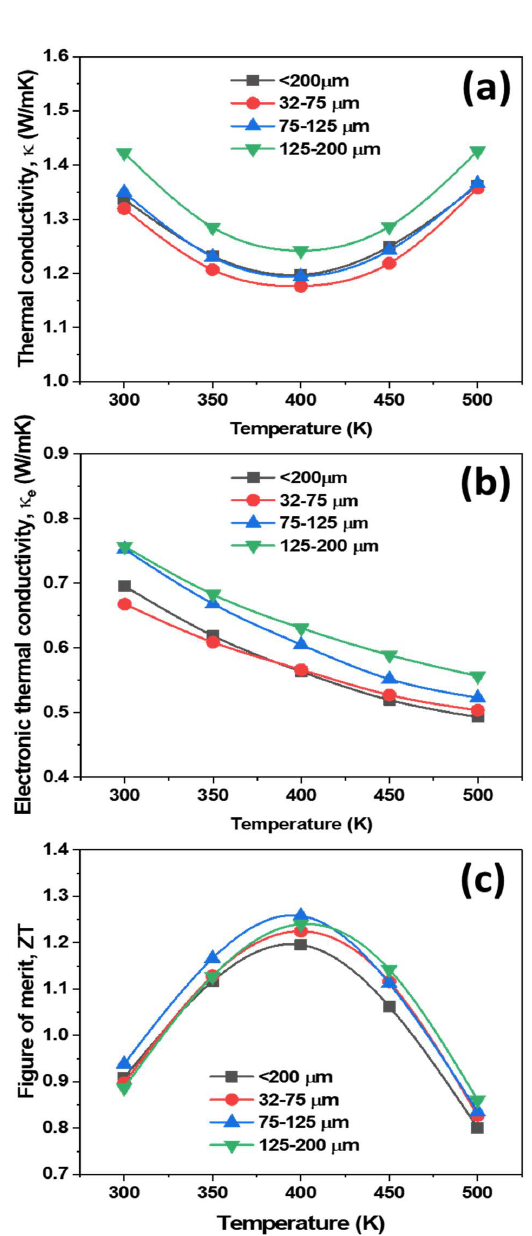
Figure 6. Temperature dependence of ( a ) total thermal conductivity, ( b ) electronic thermal conductivity, and ( c ) figure of merit for different water atomized powder sizes of p-type Cu 0.07 Bi 0.5 Sb 1.5 Te 3 bulk specimens.